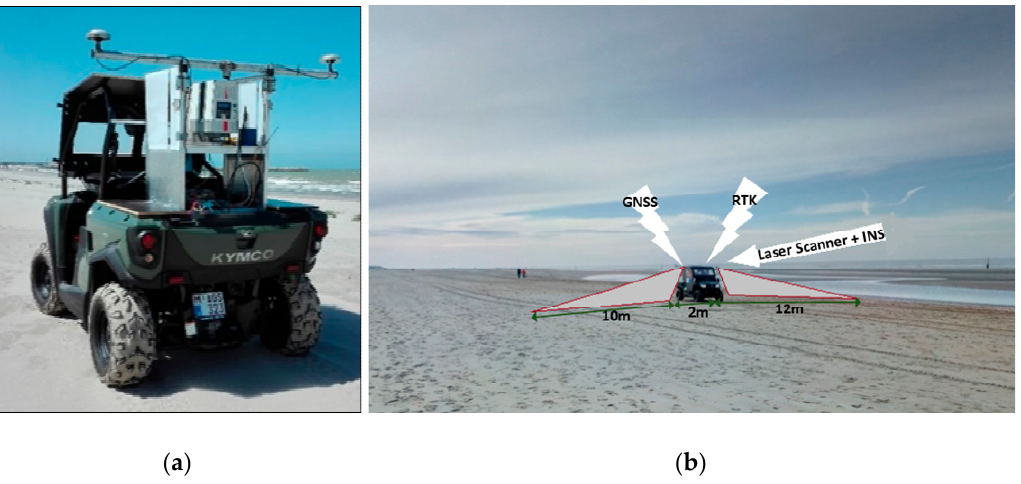
Figure 9. ( a ) Kymco mobile platform equipped with the following sensors: a Z&F / Leica HDS6100 laser scanner, an IMU and two RTK-GNSS antennas and ( b ) MTL measurement on the beach where the effective scanning range on the wet beach is about 12 m with a scanner height of 1.75 m.